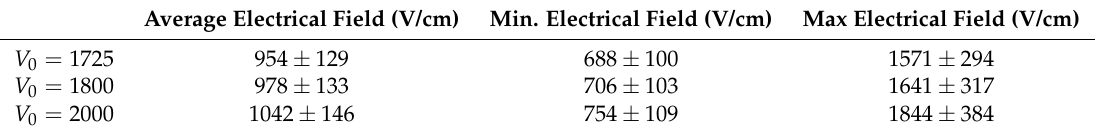
Table 2. Electrical Field Statistics within the Tumor. Varying σ 0 for liver tissue.